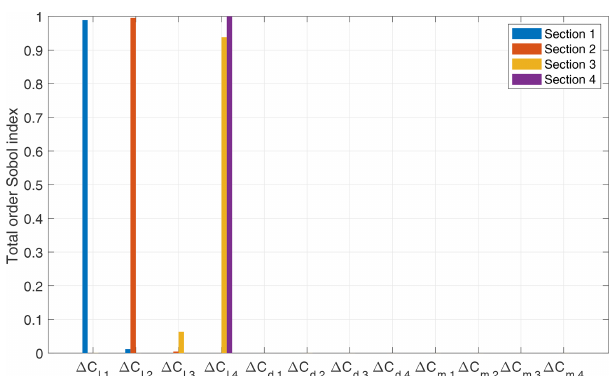
Figure B2. Sensitivity of sectional normal force with respect to perturbations in airfoil polars with original